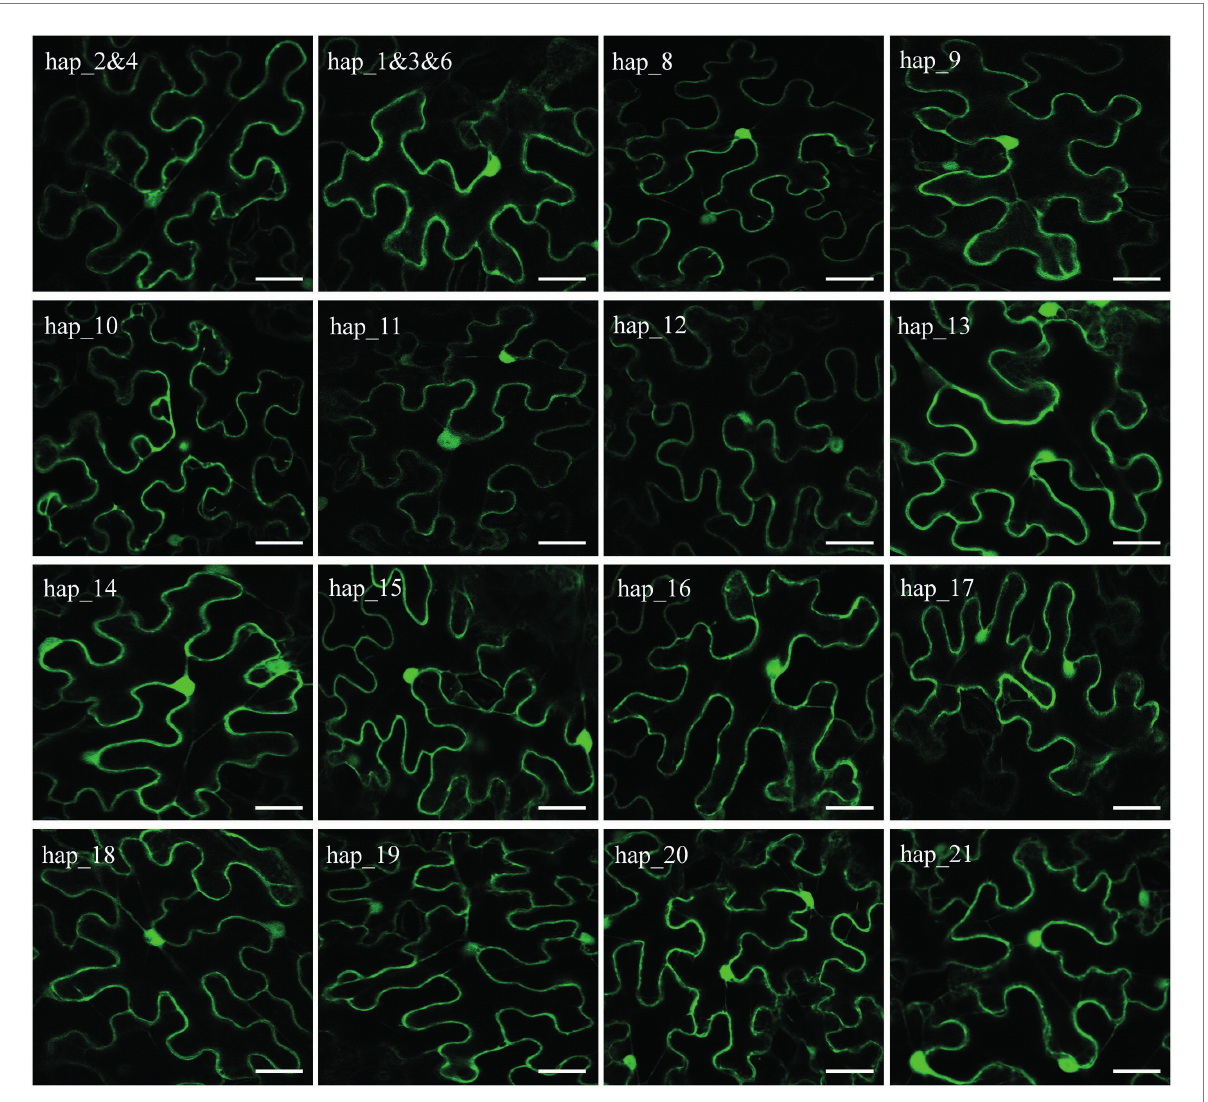
FIGURE 4 Confocal images showing that GFP- Pi02860 effectors are localized in the cytoplasm and nucleus. Scale bars are 20 μ